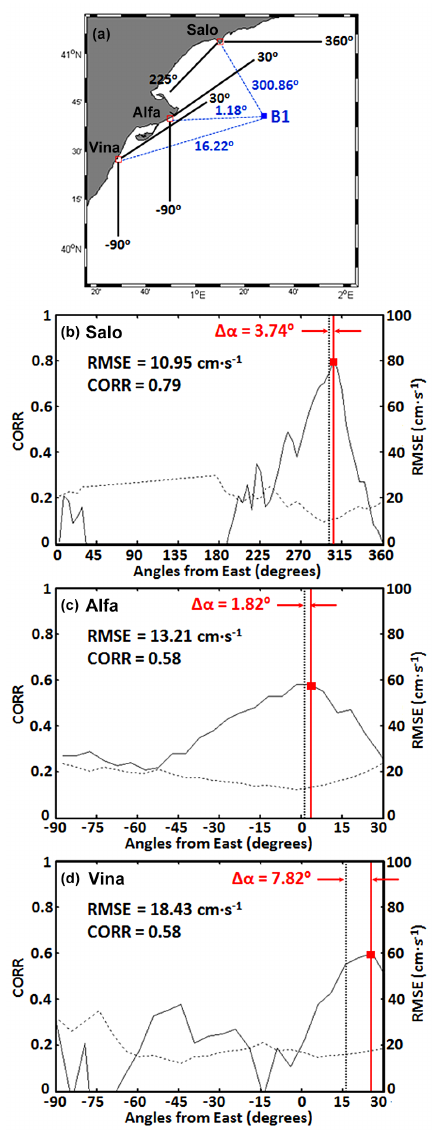
Figure 4. (a) Angular position of Ebro delta HF radar sites with re- spect to the B1 buoy location. Angle values are measured counter- clockwise from east, indicating arc limits and buoy direction. (b–d) Correlation (solid line) and RMSE (dashed line) between unfiltered radial currents estimated by the B1 buoy and those measured by three HF radar sites, SALO (b) , ALFA (c) , and VINA (d) , using cal- ibrated antenna patterns for a 6-month period May–October 2014. The vertical dotted line represents the angular position of B1. The vertical red solid line denotes the angular position of maximum cor- relation (CORR), which is gathered with the associated RMSE and bearing offset ( (cid:49)α) values.